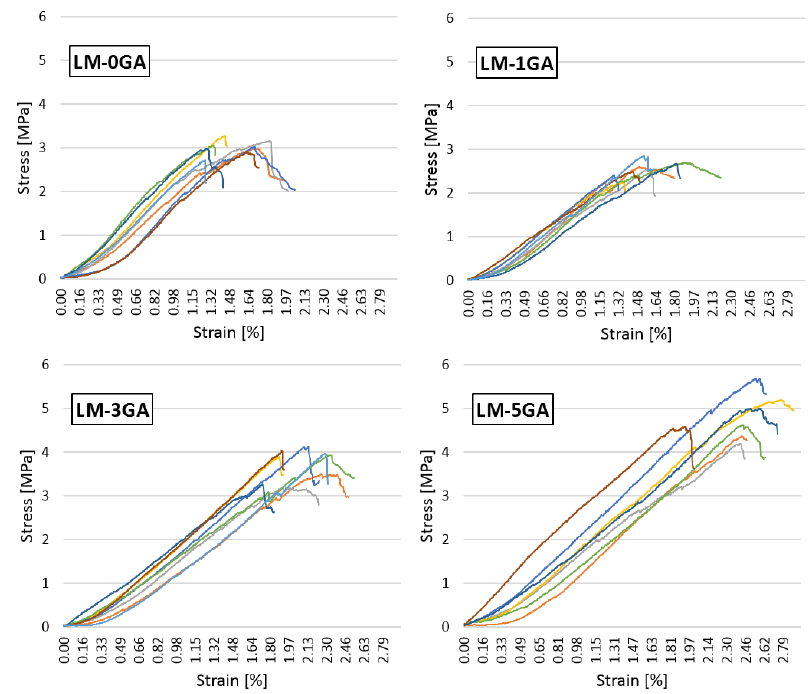
Figure 9. The dependence of the stress on the strain. Figure 9. The dependence of the bending force on the displacement of the press head. The averaged values of flexural and compressive strengths are shown in Figure 10.